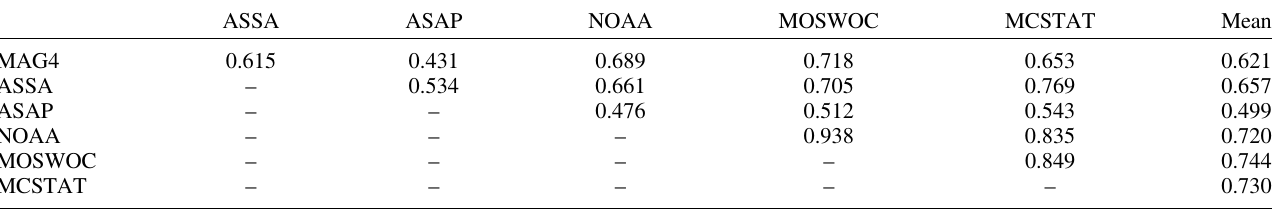
Table 2. Matrix of Pearson ’ s R correlation coef fi cients calculated among M-class fl are forecast time series shown in Figure 2, right panel. The mean value for each method is calculated using all the non-zero values in the column and row that corresponds to such